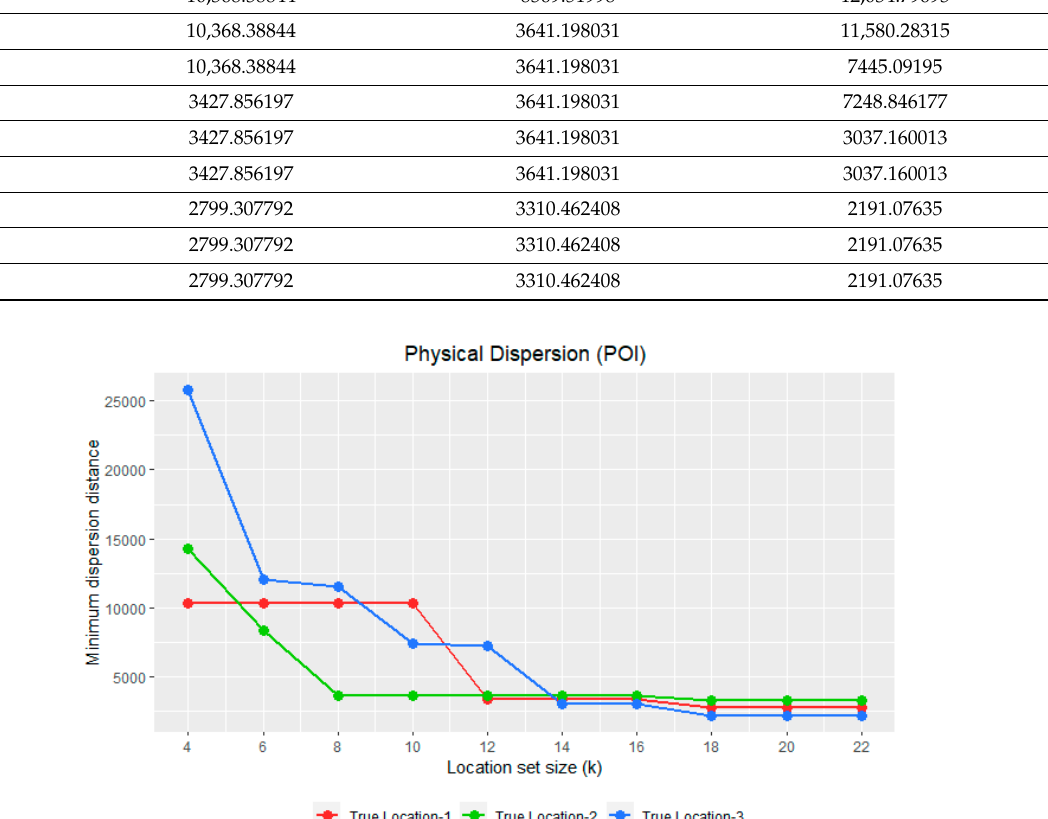
Figure 7. Plots show physical dispersion of POI locations within a location set with the size of location